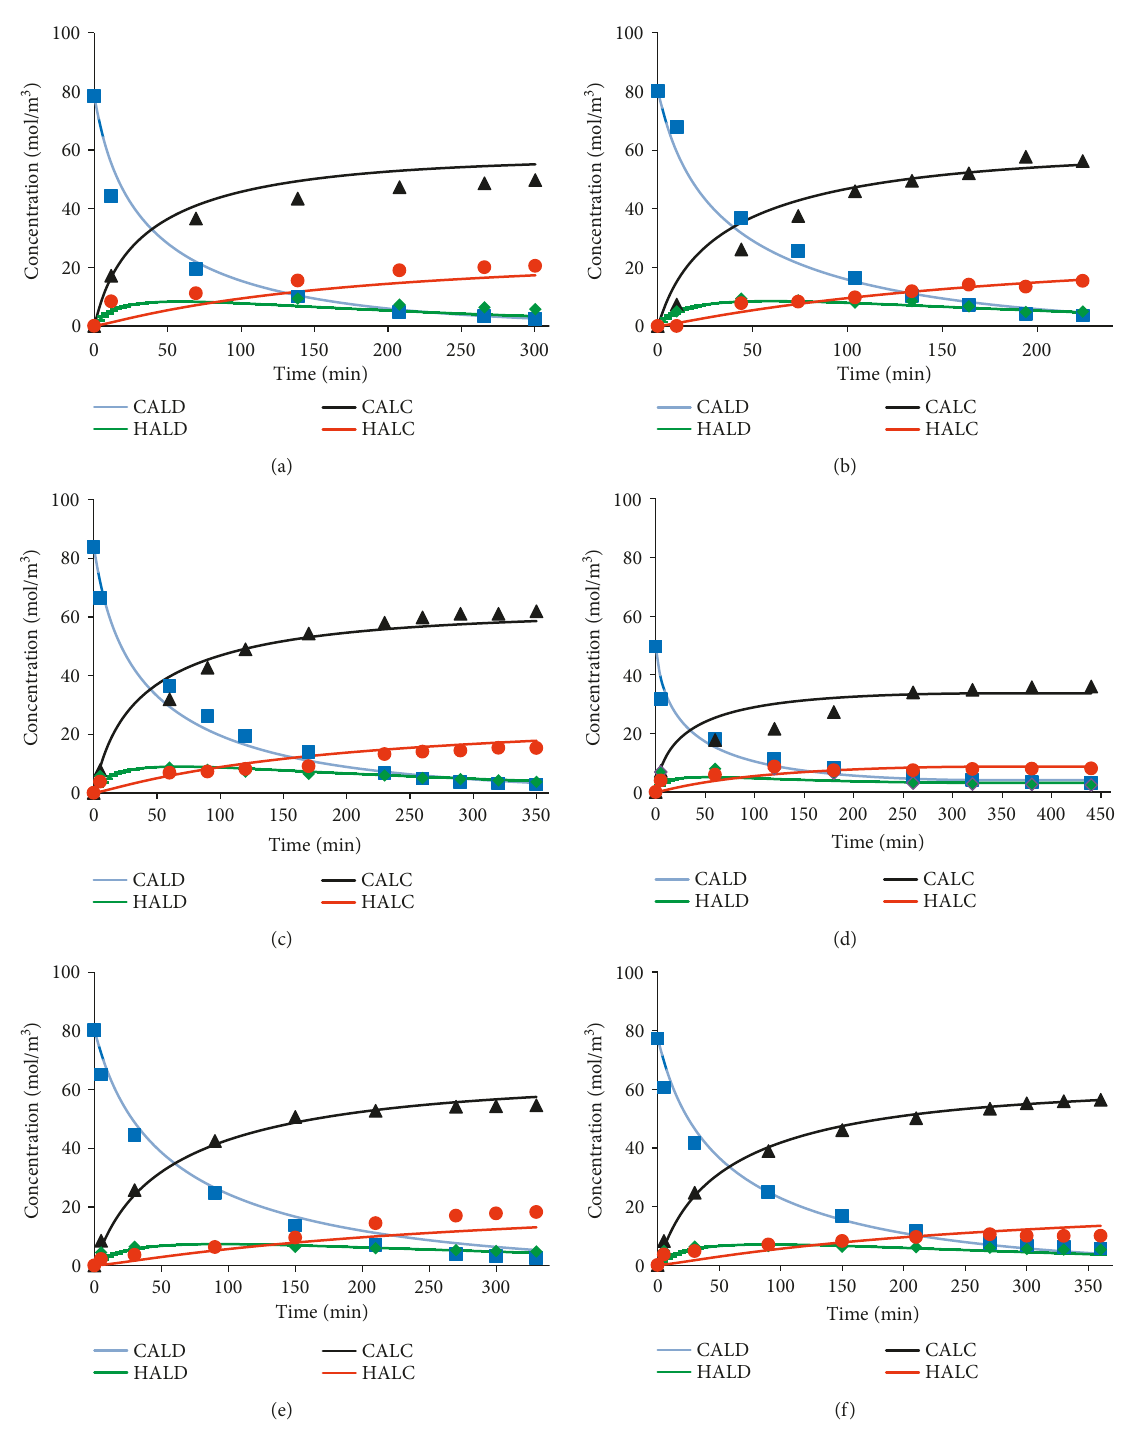
Figure 5: Comparison between the experimental and intraparticle diffusion model results. Experimental conditions are (a) ( T � 110 ° C, P � 30 bar, initial CALD concentration � 78.25mol/m 3 ), (b) ( T � 110 ° C, P � 30 bar, initial CALD concentration � 80.19mol/m 3 ), (c) ( T � 110 ° C, P � 20 bar, initial CALD concentration � 83.88mol/m 3 ), (d) ( T � 110 ° C, P � 10 bar, initial CALD concentration � 49.57mol/ m 3 ), (e) ( T � 90 ° C, P � 30 bar, initial CALD concentration � 80.15mol/m 3 ), and (f) ( T � 90 ° C, P � 30 bar, initial CALD concentration � 77.23mol/m 3